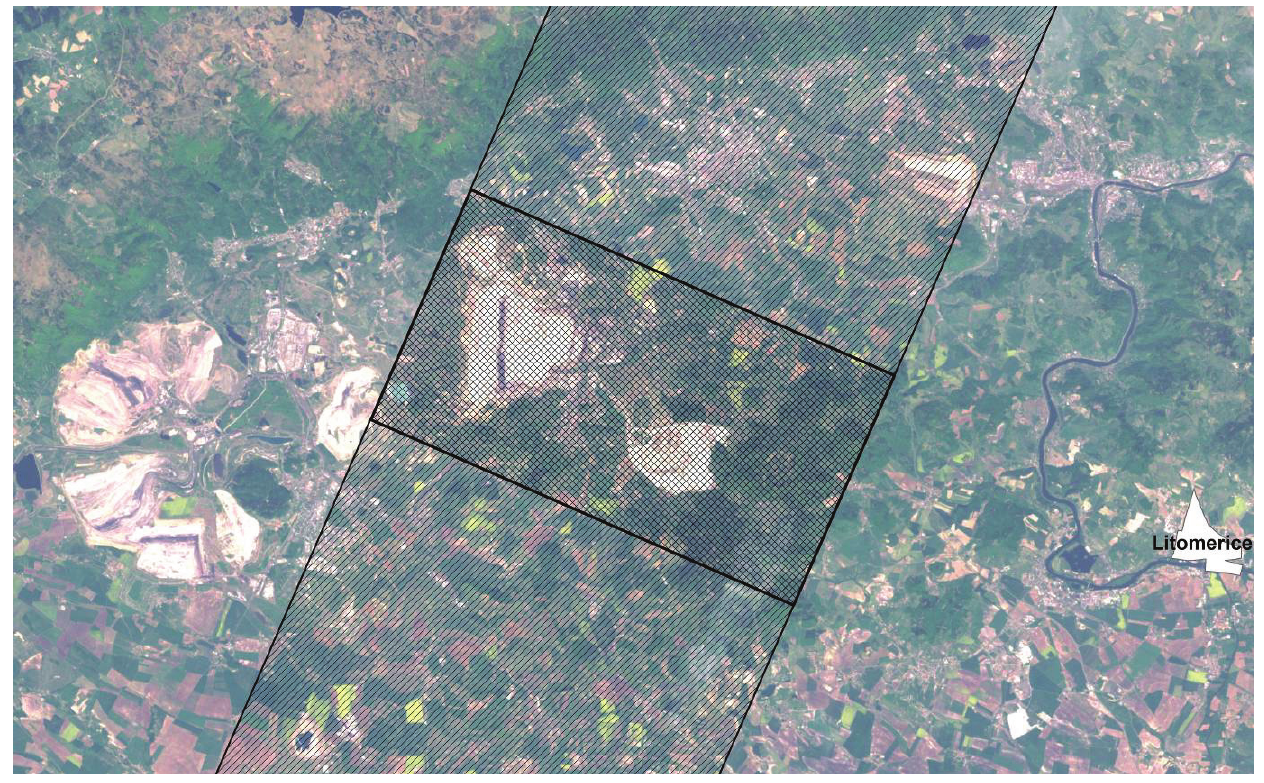
Figure 2. A study area within a central portion of the scene in a strip of the Landsat 7 ETM+